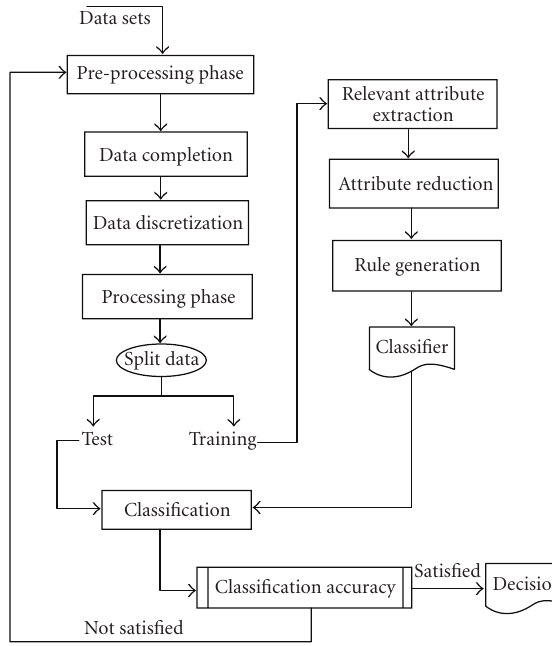
Figure 1: Overall rough sets data analysis